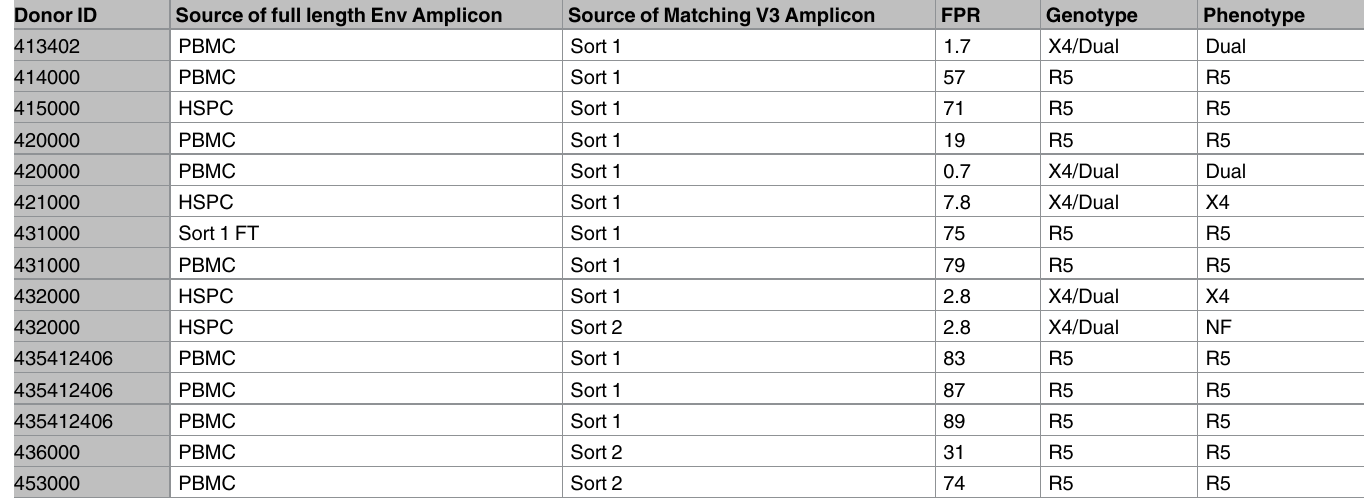
Table 4. Summaryof Env phenotypes with V3 regions matching HSPC-associated env